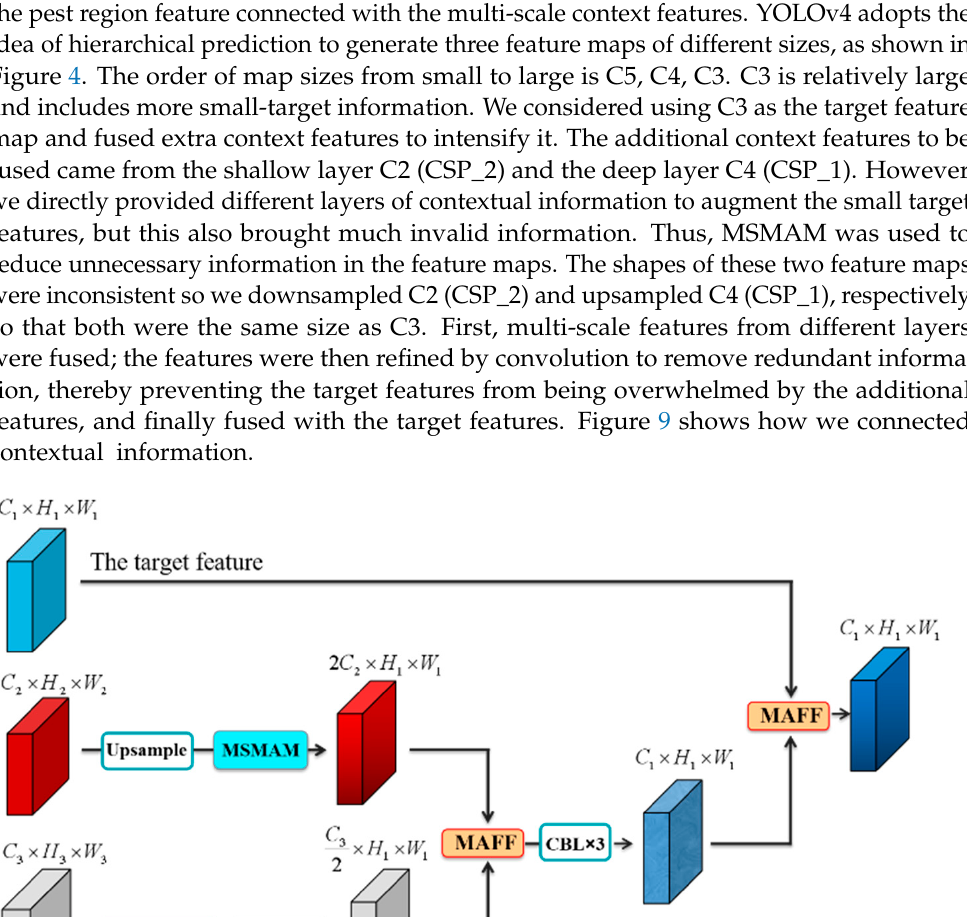
Figure 10. MAFF structure. 3. Results and Discussion In this section, we verify and analyze the method proposed in this paper through different combined comparative experiments on different growth cycle data; the experi- mental datasets are DV12, DVT, and DV12&DVT—a combination of the former two. The specific experimental environment is shown in Table 1. Table 1. Experimental environment. Configuration